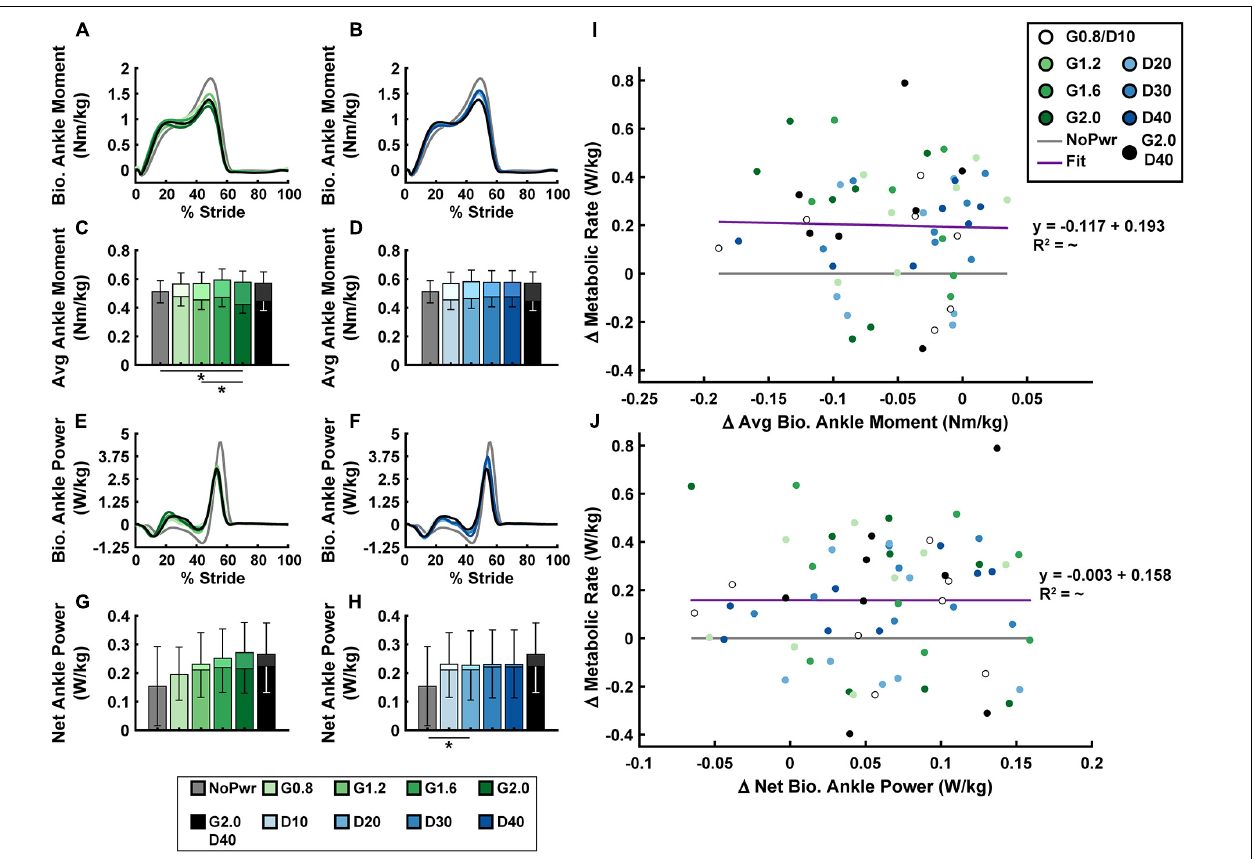
FIGURE 5 | Users’ biological ankle mechanics versus metabolic rate. Measurements of users’ average biological ankle moment (A,B) and power (E,F) over a stride from heel strike (0%) to heel strike (100%) of the same leg are shown. Ankle plantarflexor torque is depicted as positive. Positive/negative power indicates net energy generation/absorption by the biological structures acting about the ankle. Bar graphs are average biological (darker bars in front) and total = bio + exo (lighter bars in back) ankle moment (C,D) and net ankle power (G,H) . All measurements are averages across the study participants ( N = 9) in each condition with varying neuromuscular model (NMM) controller reflex Gain (green) in left panel (A,C,E,G) and Delay (blue) in the right panel (B,D,F,H) . Linear regressions between the change in metabolic rate versus the change in average biological ankle moment with respect to the unpowered (NoPwr) condition (I) and the change in metabolic rate versus the change in net biological ankle power with respect to the unpowered (NoPwr) condition (J) . * denotes pairwise significant difference of p < 0.05. R 2 value is denoted with a “ ∼ ” if the linear regression was not statistically significant. Conditions are abbreviated and color coded as follows: unpowered (NoPwr) (gray), NMM reflex Gains of 0.8, 1.2, 1.6, and 2.0 all with reflex Delay = 10 ms (G0.8, G1.2, G1.6, and G2.0, respectively) (green), NMM reflex Delays of 10, 20, 30, and 40 ms all with a reflex Gain = 1.2 (D10, D20, D30, D40, respectively) (blue), and a high-Gain-high-Delay condition (G2.0 D40)